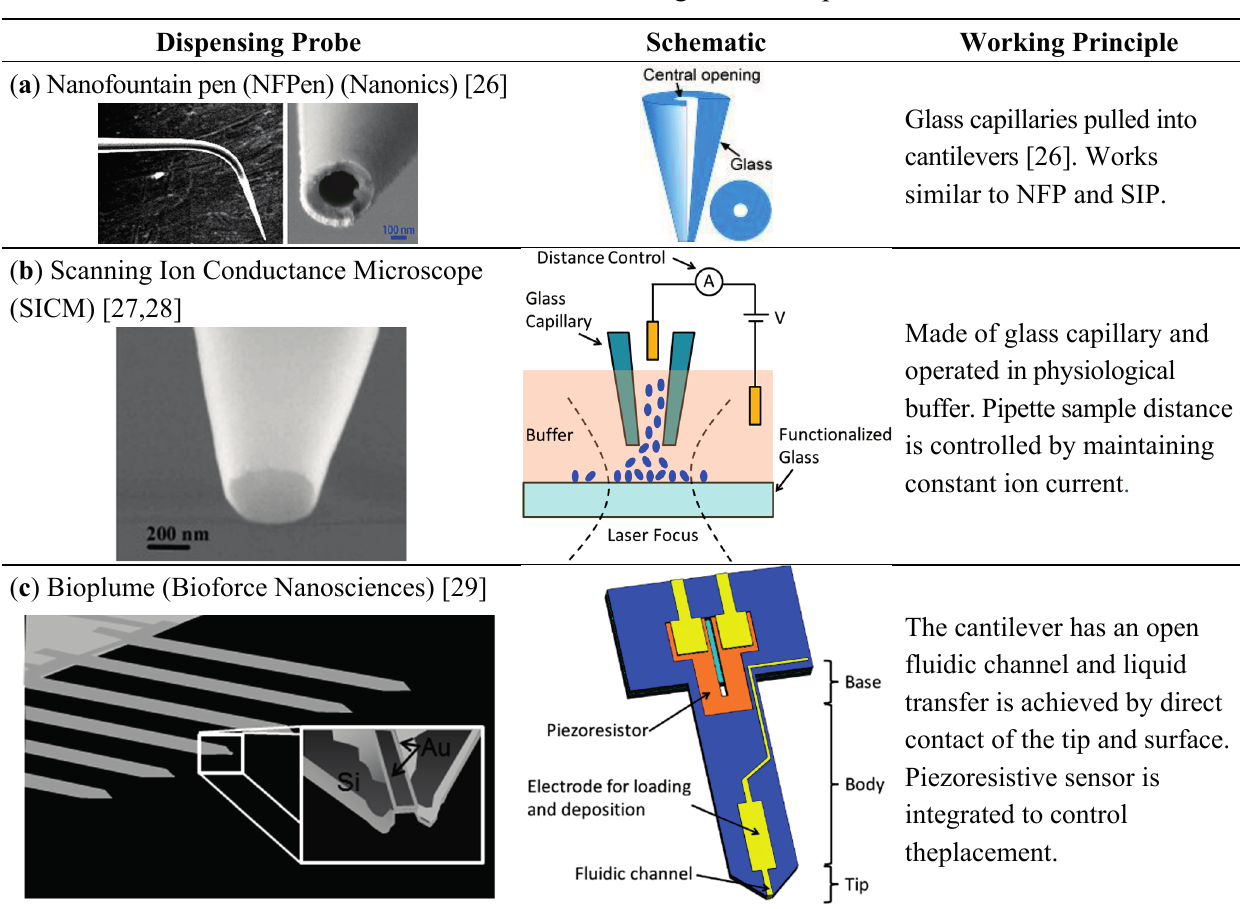
Table 2. Other fluid handling nanoscale